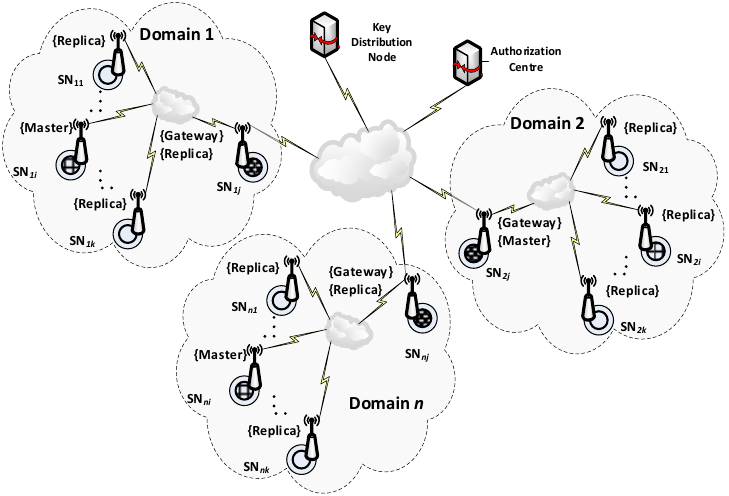
Figure 1. The way various domains cooperate with the key distribution node.